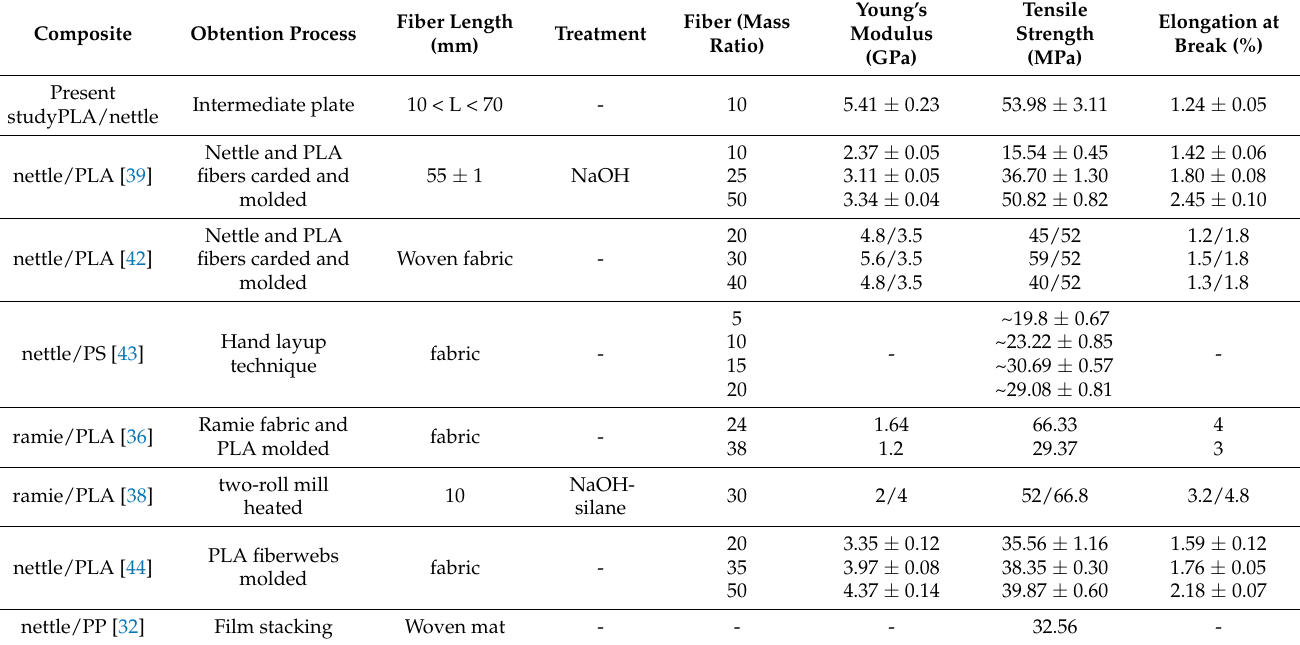
Table 5. Comparison of the mechanical properties of the obtained PLA/nettle composite with literature